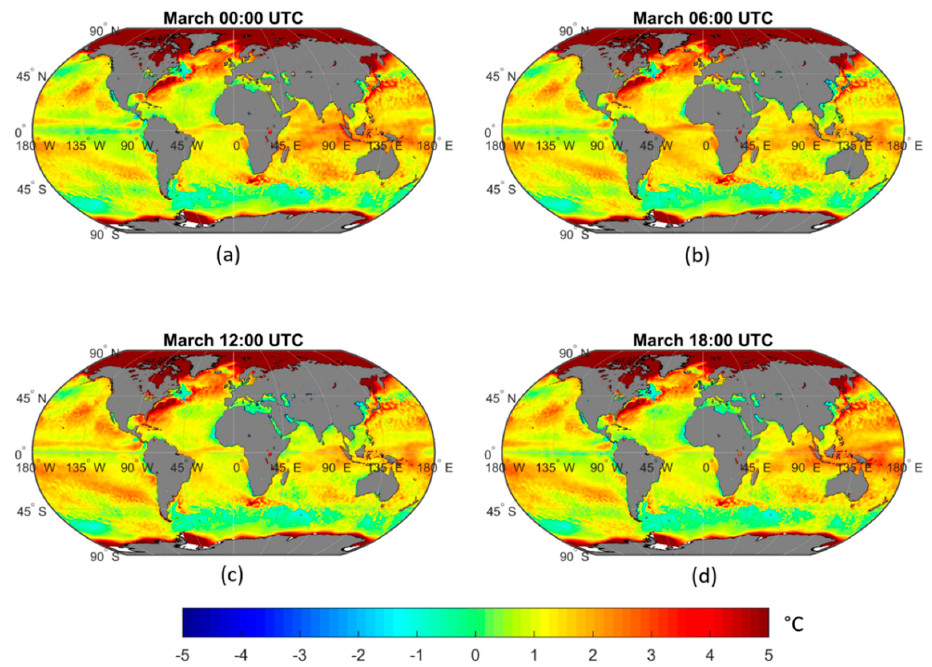
Figure B1. Global maps of monthly average of SST- t2m in the month of March 2018, calculated using ERA5 324 data [17], for the time steps ( a ) 00:00 UTC; ( b ) 06:00 UTC; ( c ) 12:00 UTC; ( d ) 18:00 UTC. 325